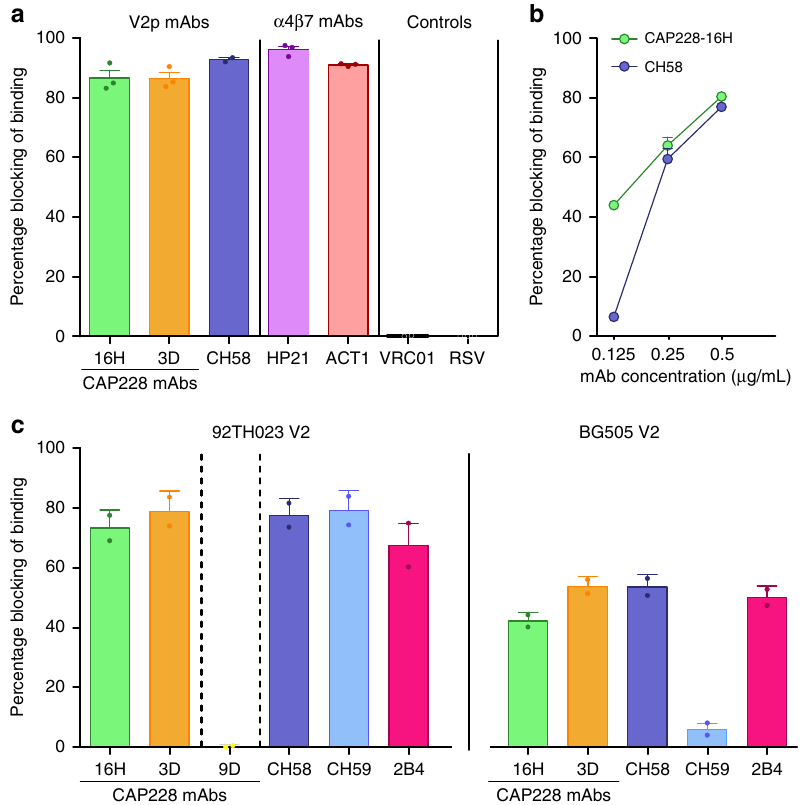
Fig. 3 CAP228 antibodies ef fi ciently inhibit α 4 β 7 integrin binding. a Inhibition of ConC gp120 binding to α 4 β 7 integrin transfected 293 T cells by V2p mAbs CAP228-16H (green), CAP228-3D (orange) or CH58 (blue). Percentage blocking (y-axis) was calculated from the difference in mean fl uorescence intensity (MFI) when cell-gp120 complexes were made in the presence or absence of antibody. The α 4 β 7 speci fi c antibodies HP21 (purple) and ACT1 (red) were used as positive controls, while an irrelevant RSV antibody (palivizumab) and an HIV-1 CD4 binding site-speci fi c antibody (VRC01) were used as the negative controls. b Ability of V2p antibodies CAP228-16H (green) or CH58 (blue) to block adhesion of α 4 β 7 integrin expressing RPMI8866 cells to a cyclic 92TH023 peptide (residues 157 – 196) at three separate concentrations. c Inhibition of V2 peptide (strains 92TH023 or BG505) binding to α 4 β 7 integrin expressing RPMI8866 cells by V2p mAbs CAP228-16H (green), CAP228-3D (orange), CH58 (blue) and CH59 (light blue) or the conformation speci fi c non-V2p mAb CAP228-9D. The mAb 2B4 is speci fi c for the α 4 integrin and served as the positive control (pink). Data are represented as